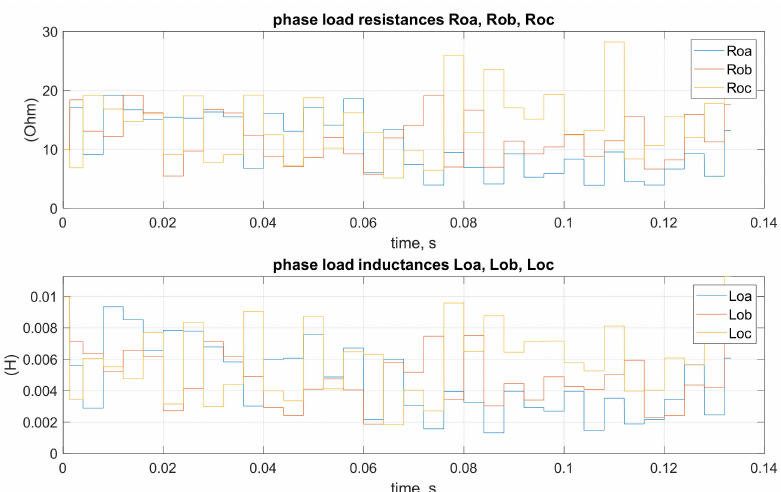
Figure 3. The resistance and inductance waveforms of the load phases of the islanded grid used in the simulation shown in the figure.